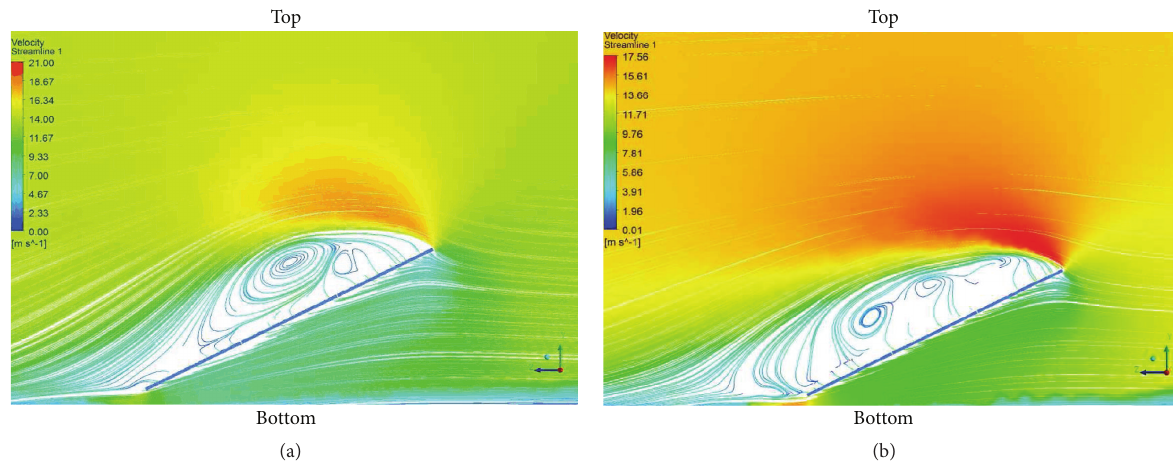
Figure 17: Streamlined velocity magnitude (m/s) contours at (a) conventional panels and (b) panels with holes, Section 1 , Figure 12, wind from right to left.